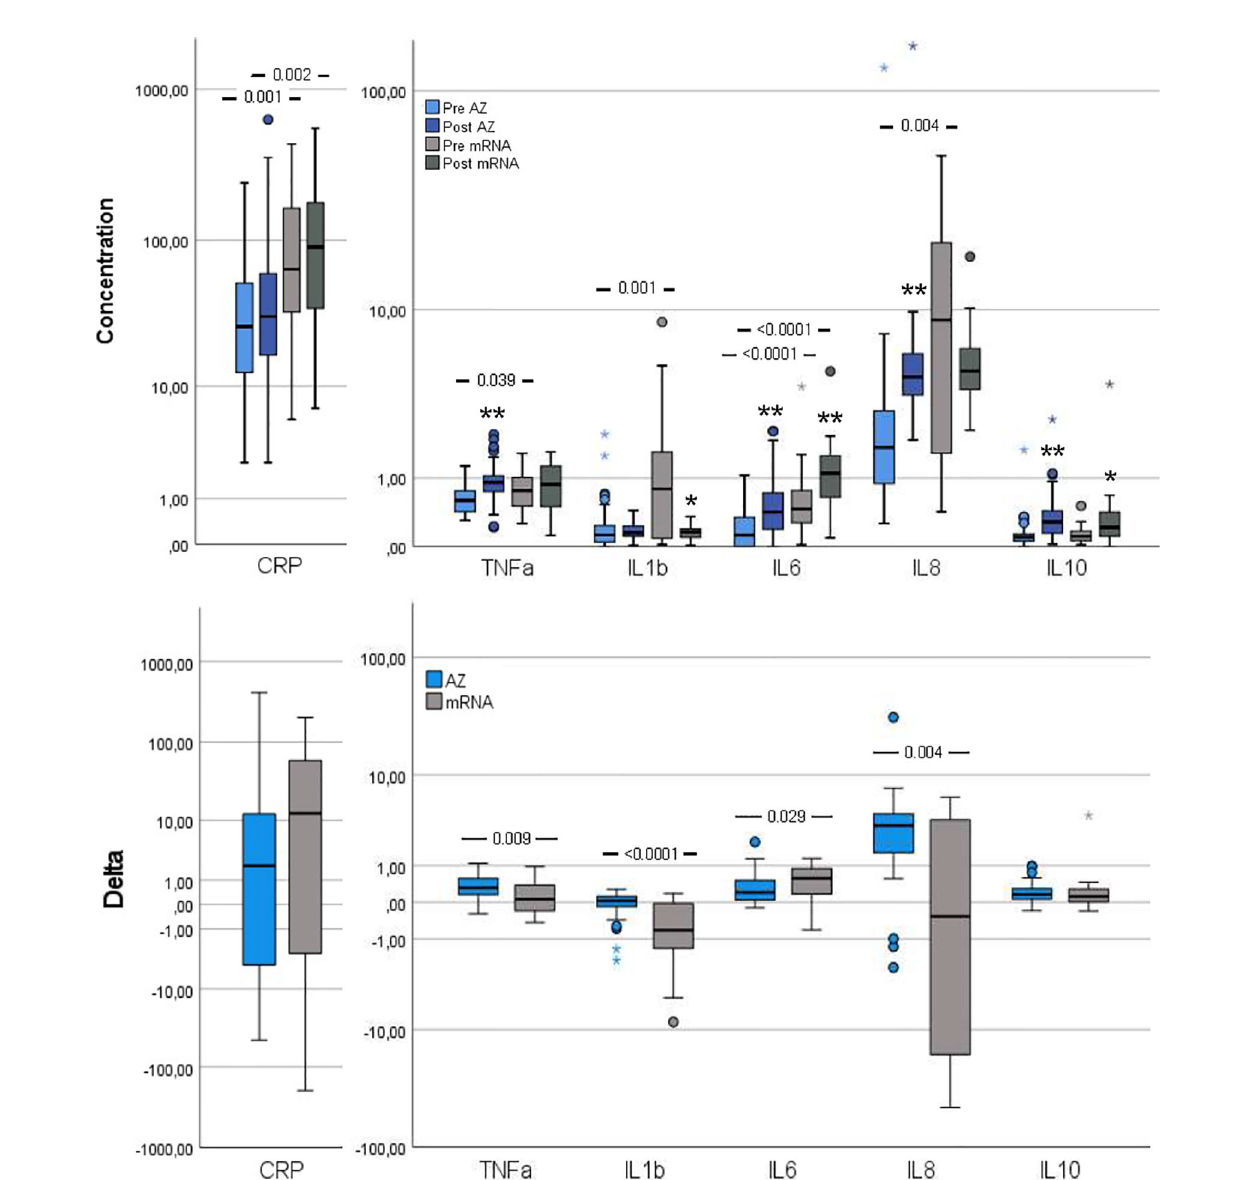
FIGURE 2 | In fl ammation markers pre- and post-vaccination and delta changes with either AZ (n=55) or mRNA (n=25) vaccines. Levels of C-reactive protein (CRP, µg/ml), Tumor necrosis factor (TNF)- a (pg/ml), interleukin (IL)-1 b (pg/ml), IL-6 (pg/ml), IL-8 (pg/ml) and IL-10 (pg/ml) are displayed on log scales. The top fi gure displays pre- and post-vaccination values, and the bottom fi gure displays delta changes. The box plots display median, fi rst and third quartile (box mid-line, button and top, respectively) and the whiskers display maximum and minimum values with outliers (circles) and extremes (small asterisks) displayed. AZ vaccinated individuals are displayed by blue bars (top fi gure: pre=light blue, post=dark blue) and mRNA vaccinated individuals are displayed by gray bars (top fi gure: pre = light gray, post=dark gray). Differences between AZ and mRNA vaccinated individuals either pre- and post-vaccination and delta changes are investigated by Mann- Whitney U test, with p-values displayed. Changes over time within the AZ or mRNA groups are investigated by Wilcoxon signed-rank test, with **p < 0.0001 and *p < 0.010 (displayed over the post-vaccination